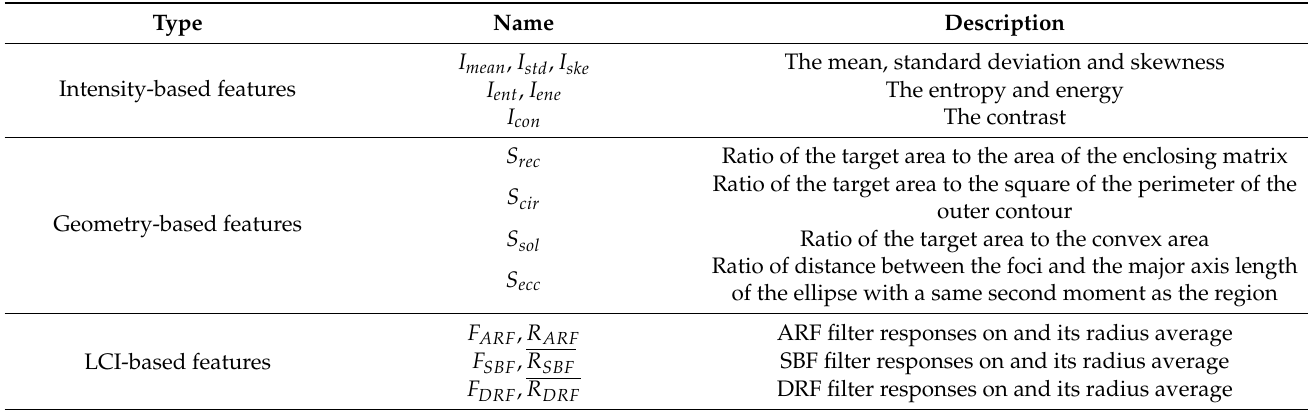
Table 1. Description of extracted features in multi-feature